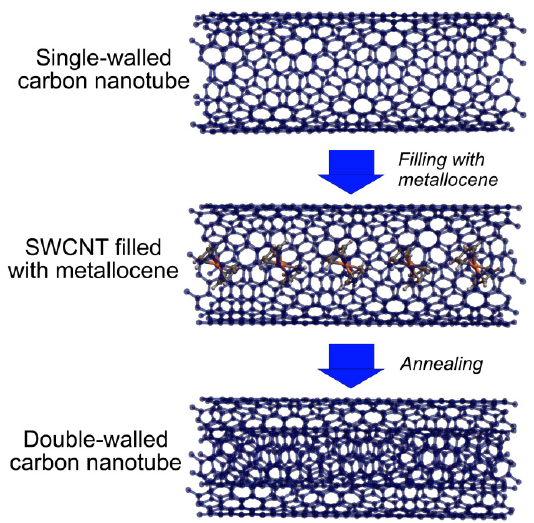
Figure 1. The schematics of the synthesis process of DWCNTs from metallocene-filled SWCNTs.